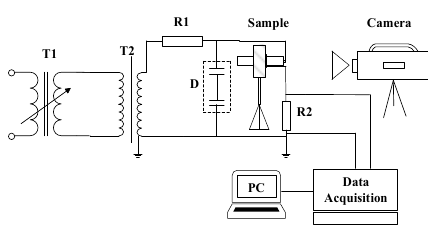
Figure 1. Schematic diagram of the test circuit. T1, Regulator; T2, Transformer; R1, Protective resistor; D, Voltage divider; R2, Non-inductive resistor.